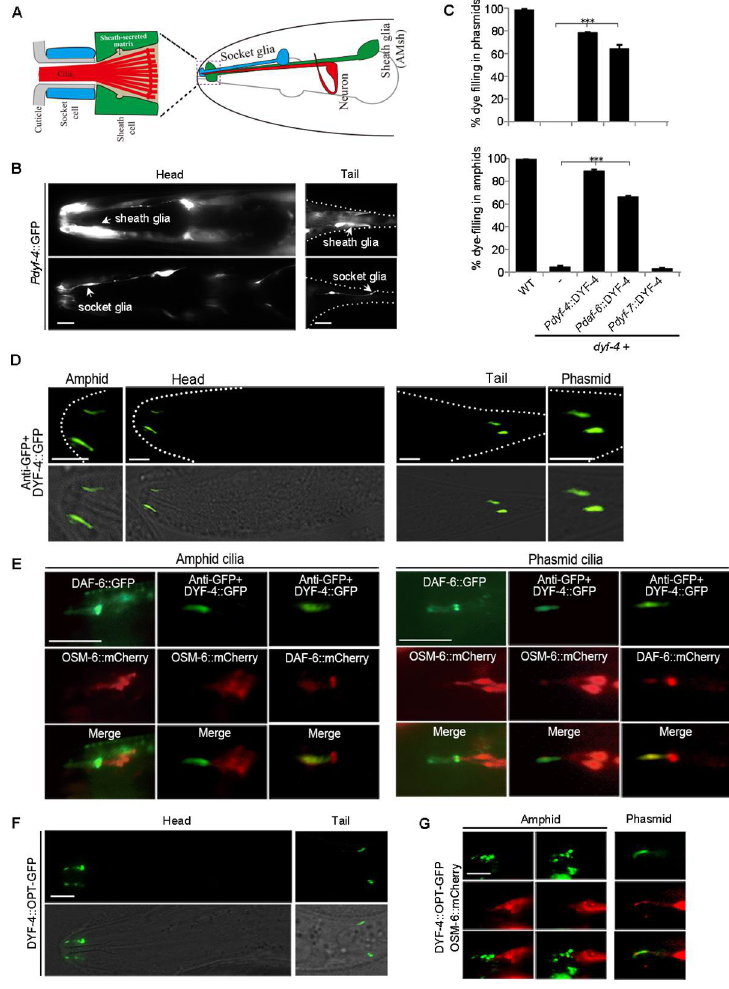
Fig 3. DYF-4 is a glial secretory protein. (A) Illustration of the C . elegans amphid. Right: Each amphid consists of 12 sensory neurons, a socket glial cell and a sheath glial cell. Left: Detail of the sensory compartment in the amphid. (B) Fluorescence micrographs of the dyf-4 expression pattern in the head and tail region in worms expressing Pdyf-4 ::GFP. Sheath glial cells and socket glial cells are indicated by arrowheads. Scale bar: 5 μ m. (C) The percentages of dye filling in amphid and phasmid in WT and dyf-4(m158) mutants expressing the WT dyf-4 gene driven by different promoters. Data are presented as the mean ± SEM from three independent experiments (n � 80 per experiment). ��� P < 0.001 (Fisher’s Exact test). (D) Representative images of DYF-4::GFP localization in the amphids and phasmids of young adult of WT. DYF-4::GFP localizes to the sensory compartment region. n = 30. Scale bar: 5 μ m. (E) Colocalization of DYF-4 and DAF-6 in the amphid and phasmid of young adult of WT. n = 10. (F) The localization pattern of DYF-4:: OPT-GFP in the amphid and phasmid of young adult of WT. Scale bar: 5 μ m. (G) Colocalization of DYF-4::OPT-GFP and OSM-6::mCherry in the amphid and phasmid of young adult of WT. DYF-4::OPT-GFP showed punctate localization and tended to accumulate at the middle of sensory compartment in amphids. Scale bar: 5 μ m.